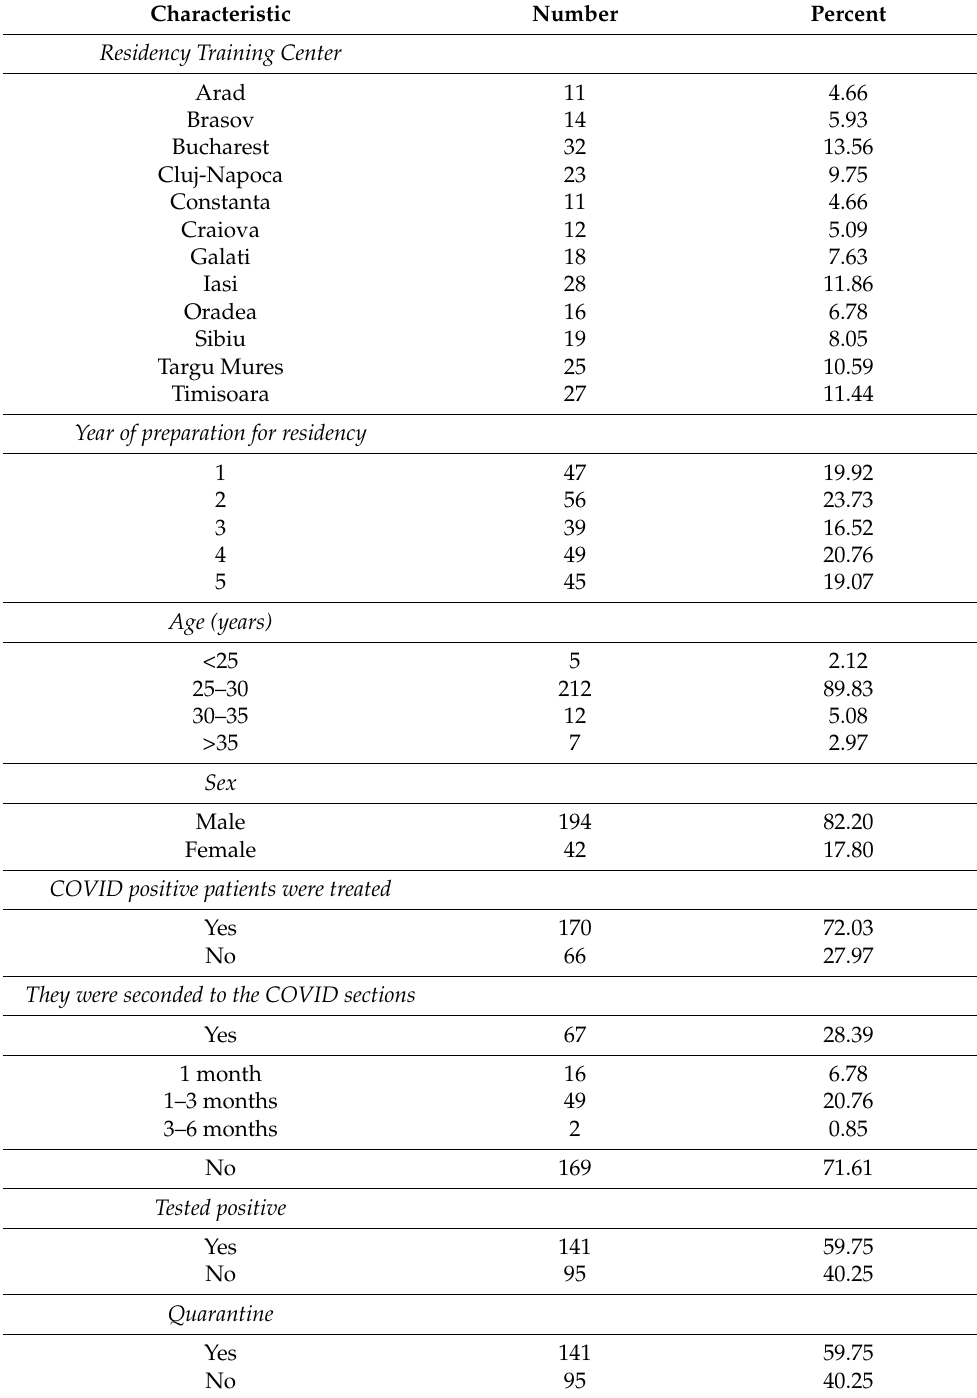
Table 1. Characteristics of the residents who participated in the